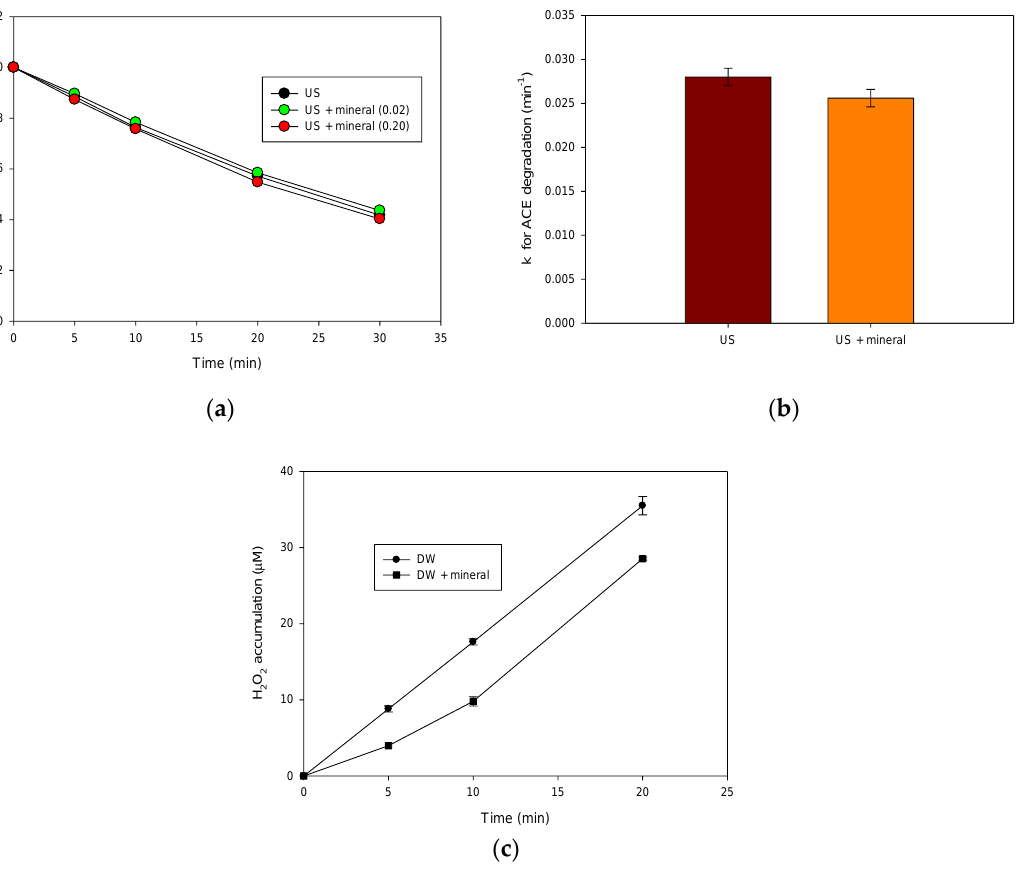
Figure 2. Heterogeneous sono-Fenton for degrading organic pollutants. ( a ) Effect of mineral con- centration on the MO degradation; ( b ) Effect of the natural mineral (at 0.20 g L −1 ) on ACE degrada- tion; ( c ) Hydrogen peroxide evolution in distilled water in the absence (DW) and presence of the solid iron source (DW + mineral) at 0.20 g L −1 . Experimental conditions: f: 375 kHz, P: 34.4 W, [MO] initial = [ACE] initial : 30.6 µmol L −1 , pH initial : 5.6, and V: 250 mL.